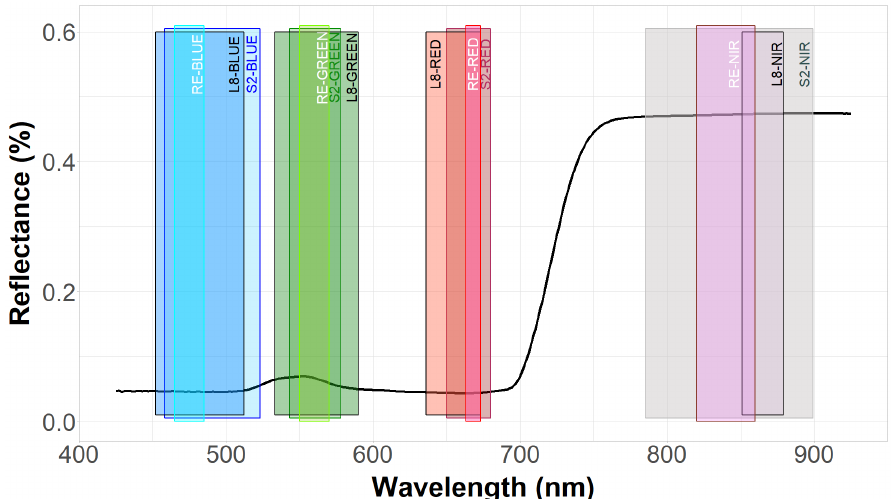
Figure 1. Comparison of wavelength channel position and widths by sensor platform (RE = RedEdge; L8 = Landsat 8; S2 = Sentinel 2), showing a typical percent reflectance spectral response signature for a grapevine